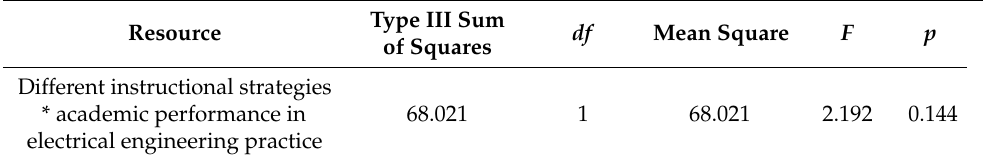
Table 9. Homogeneity of regression coefficients within groups in overall learning effectiveness